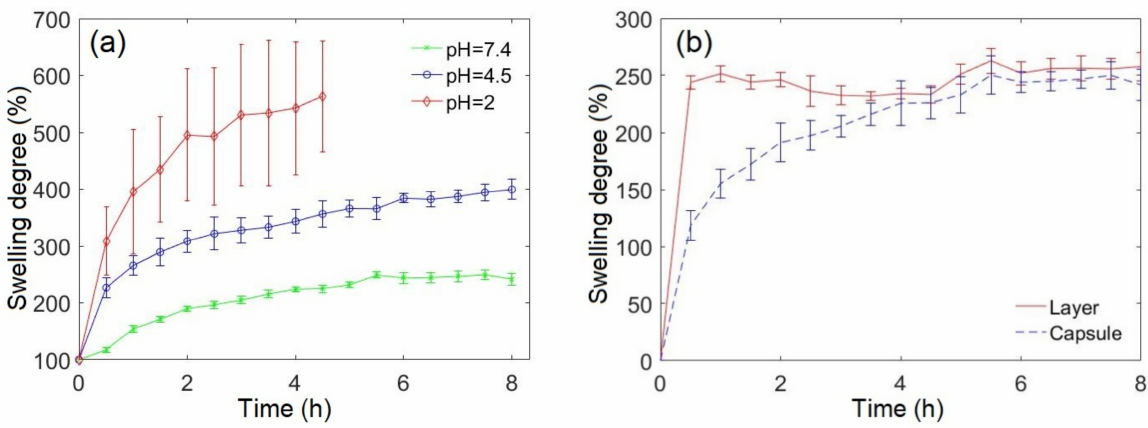
Figure 2. ( a ) Swelling behaviour of the capsules at pH = 2, pH = 4.5 and pH = 7.4. ( b ) Swelling kinetics of the capsules and the thermally crosslinked gelatin films in PBS (pH =